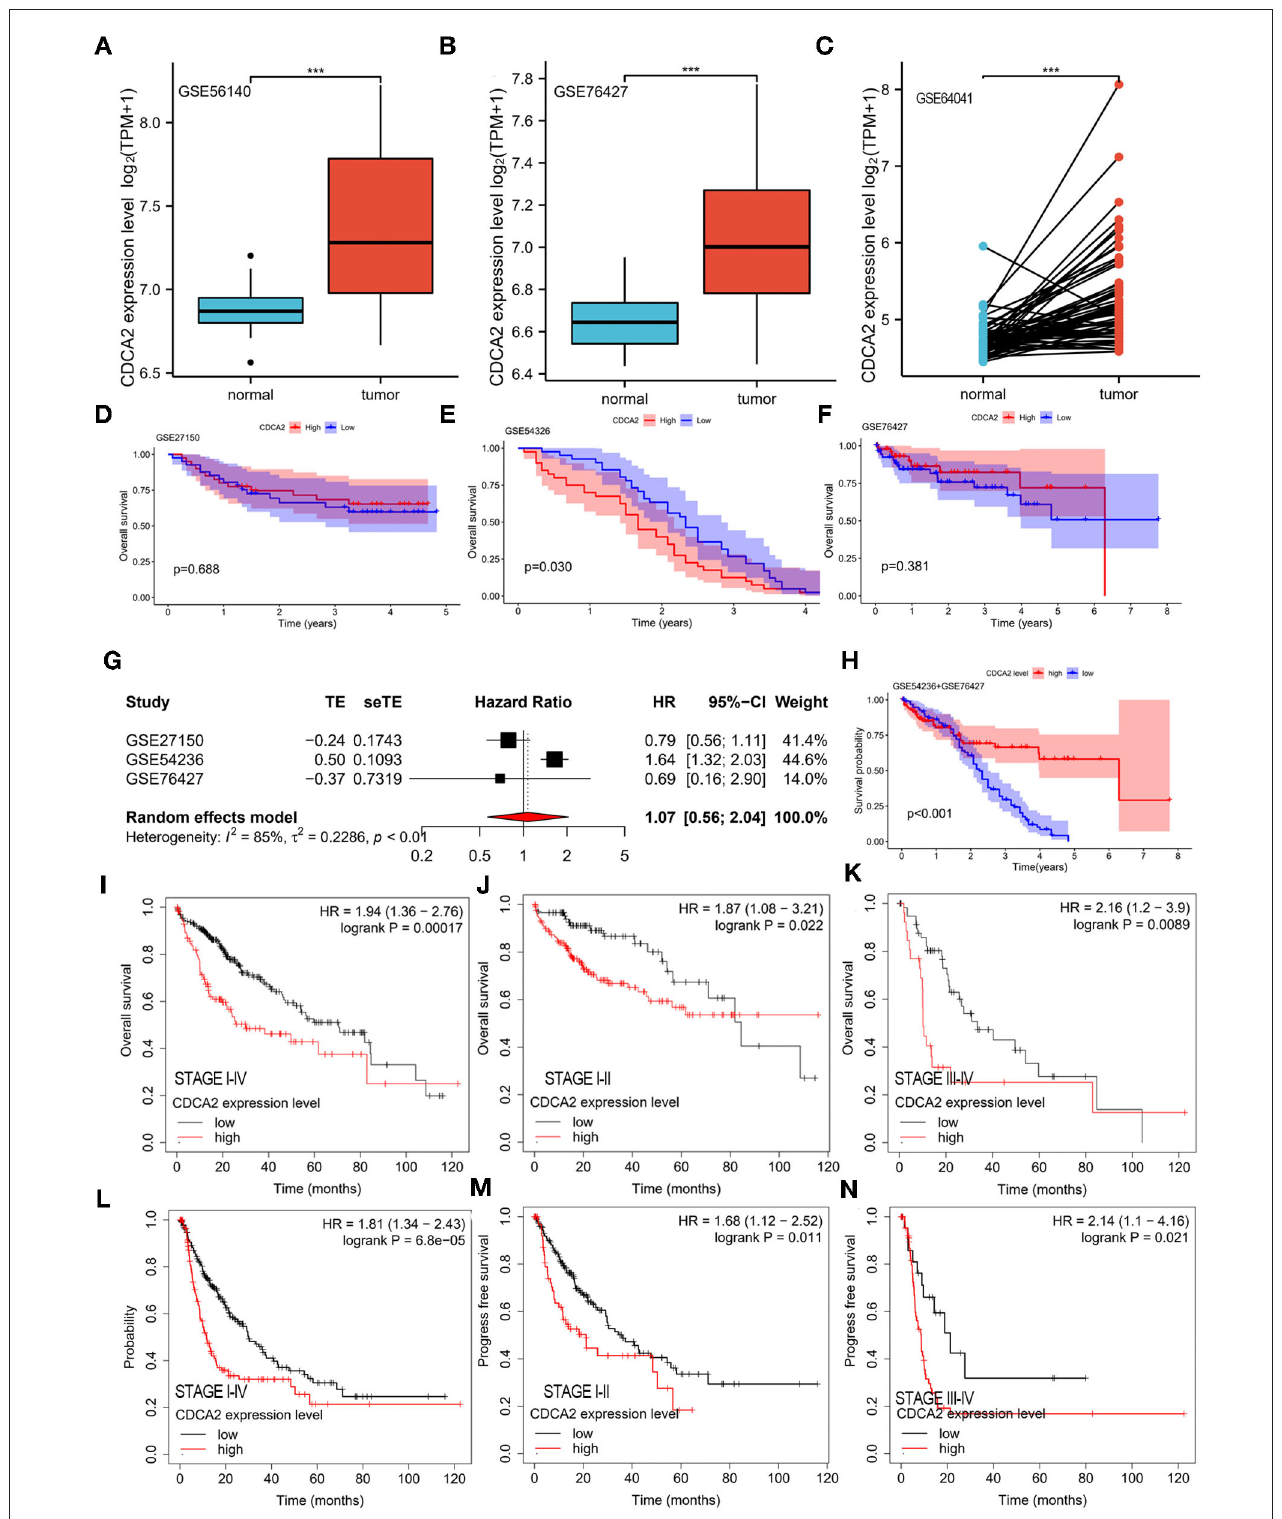
FIGURE 2 | Verification of CDCA2 overexpression in HCC and the correlation between CDCA2 expression with survival by independent datasets. Cell division cycle-associated protein 2 expression in (A) GSE56140, (B) GSE76427, and (C) GSE64041. *** p < 0.001. The overall survivals of patients with high and low CDCA2 expression in (D) GSE27150, (E) GSE54326, and (F) GSE76427. (G) Meta-analysis of hazel ratio ( HR ) of CDCA2 overexpression to survival. (H) Overall survival of patients with high and low CDCA2 expression in GSE54236+GSE 76427 cohort. (I) Overall survivals of patients with high and low CDCA2